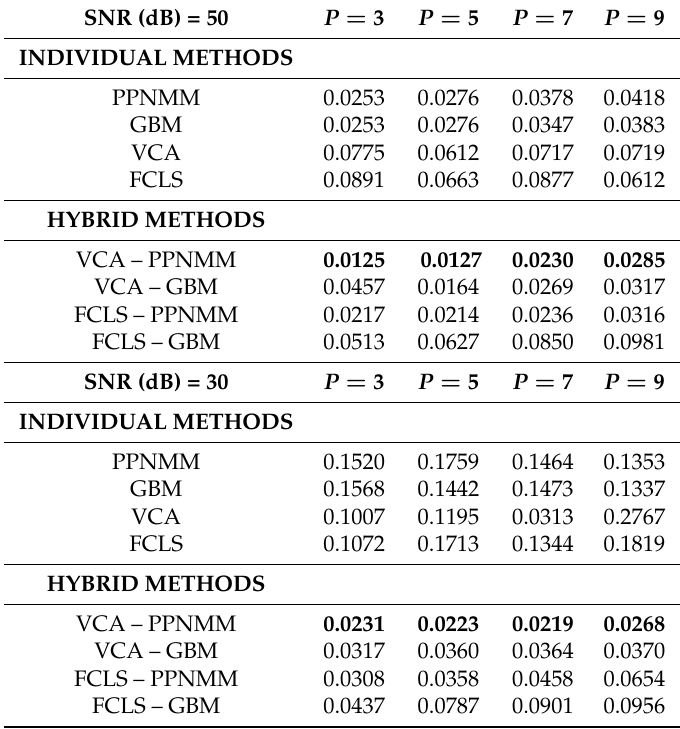
Table 3. Abundance estimation error with the individual and hybrid methods of the raw hyperspectral data between linear and nonlinear spectral unmixing with different signal to noise ratios and different endmembers. The best results are shown in